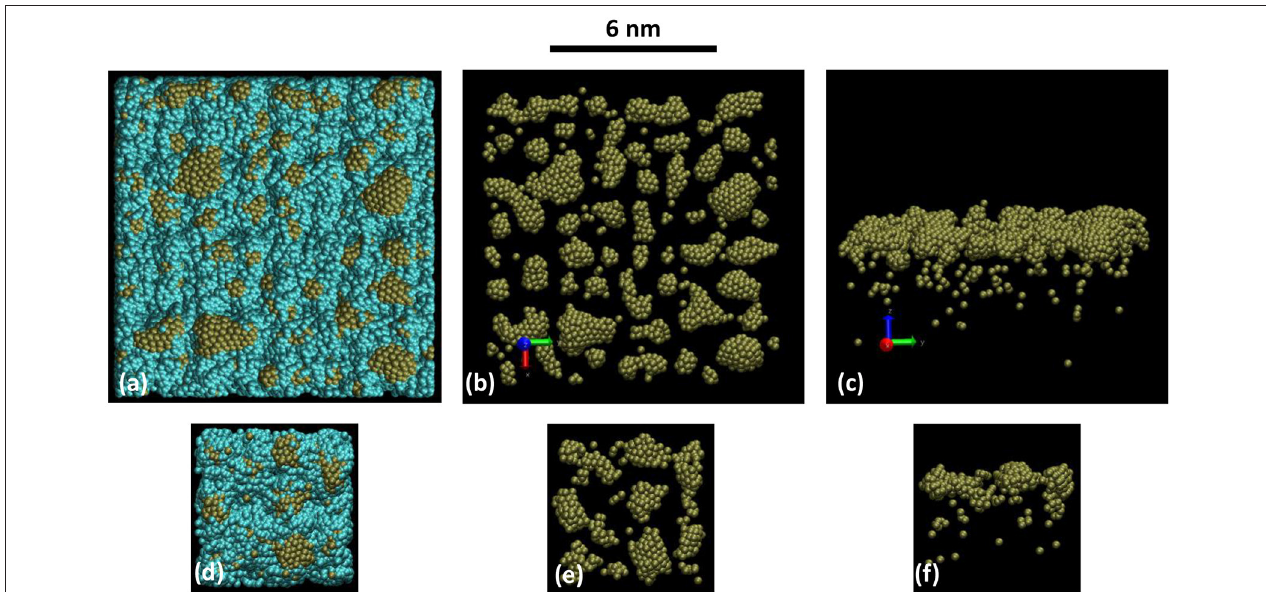
FIGURE 4 | Snapshot views of (a–c) the present simulation after 2 ns calculation time: with the substrate 12 × 12 × 6 nm 3 (a) without the substrate top (b) and side (c) views. Gas phase Ar close to the substrate are removed for clarity. And (d–f) from calculations presented in Xie et al. [ 44], on a 6 × 6 × 6 nm 3 similar porous substrate (d) without the substrate top (e) and side (f) views. The scale bar on the top of the figures holds for all pictures. The number of Pt atoms per unit area is the same. Blue and brown colored atoms are C and Pt